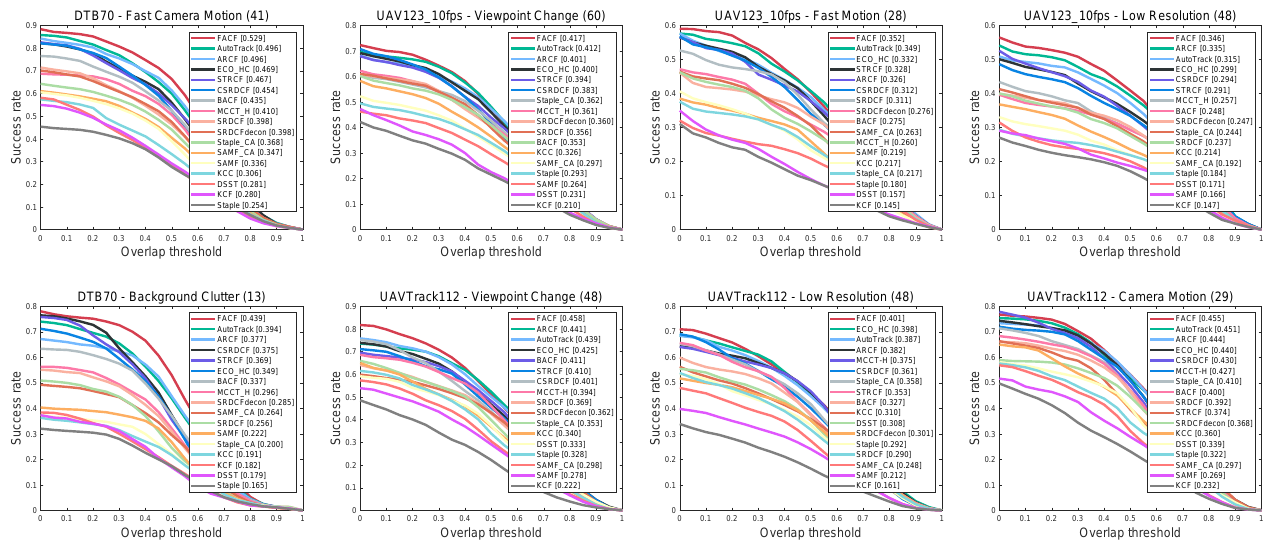
Figure 6. Attribute-based analysis of the proposed tracker and the other 16 state-of-the-art handcrafted feature-based trackers on DTB70 [25], UAV123_10fps [26] , and UAVTrack112 [27].